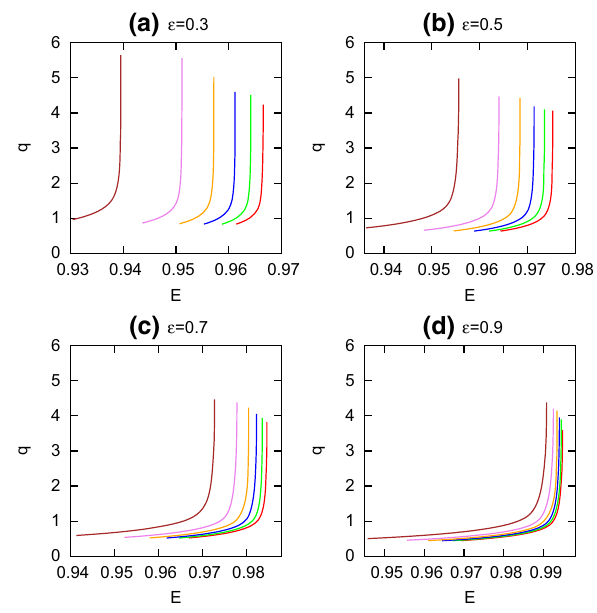
Fig. 9 The rational number q versus E by taking Q as − 1 . 5 M 2 , − M 2 , − 0 . 5 M 2 , 0, 0 . 5 M 2 , and M 2 with four cases: (cid:14) = 0 . 3, 0 . 5, 0 . 7 and 0 . 9